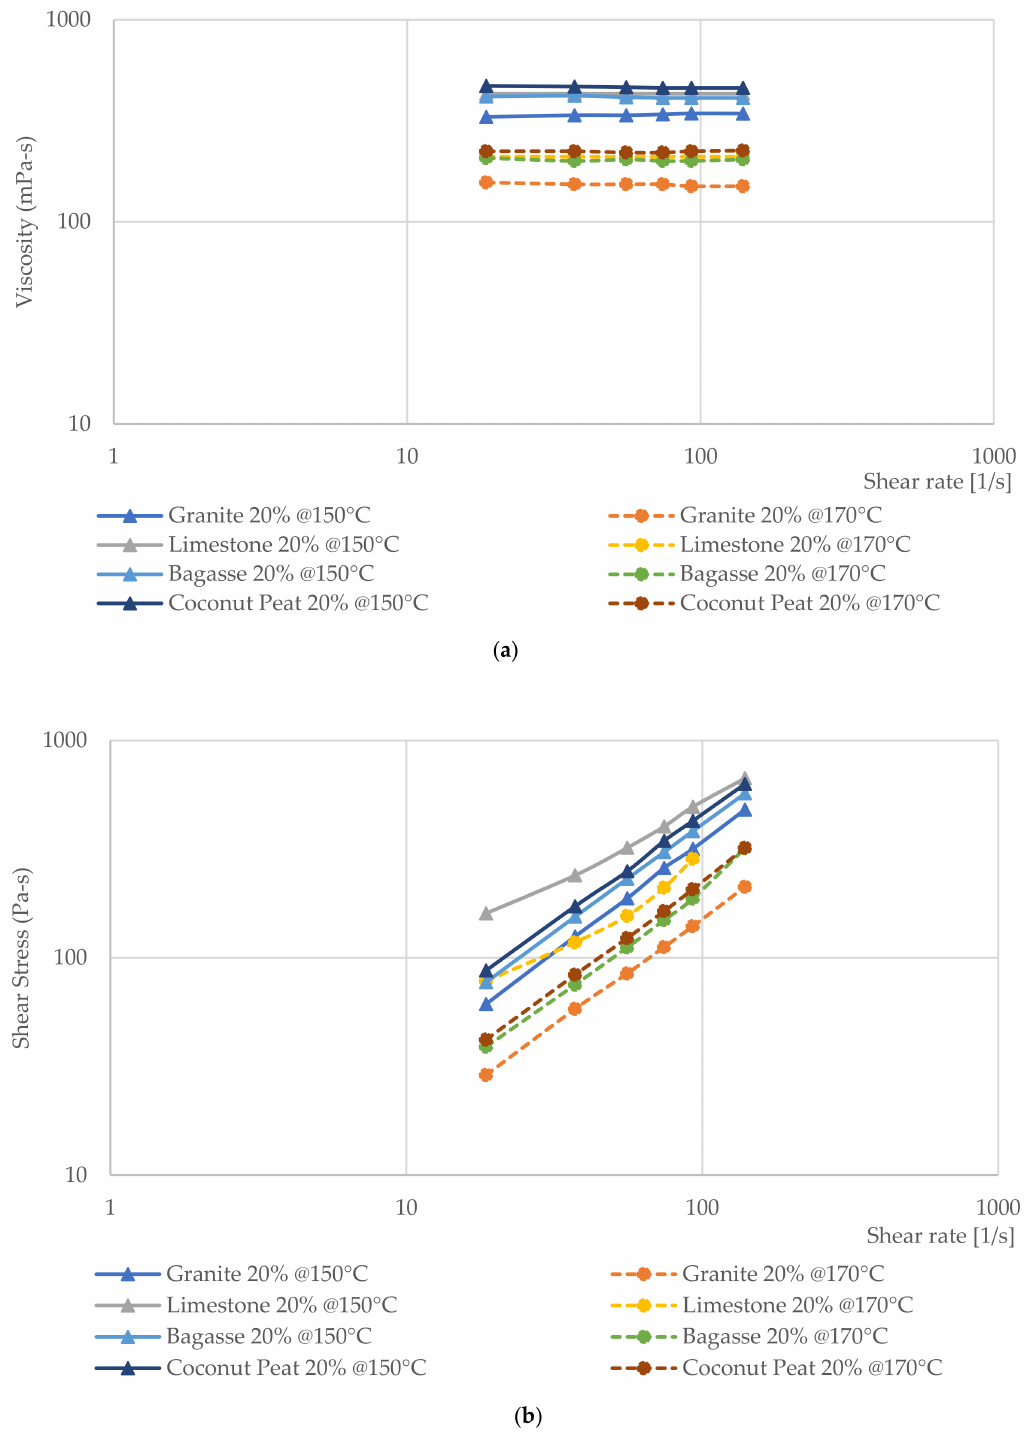
Figure 4. The relationship of asphalt mastic ( a ) viscosity and shear rate and ( b ) shear stress and shear rate at 150 and 170 ◦